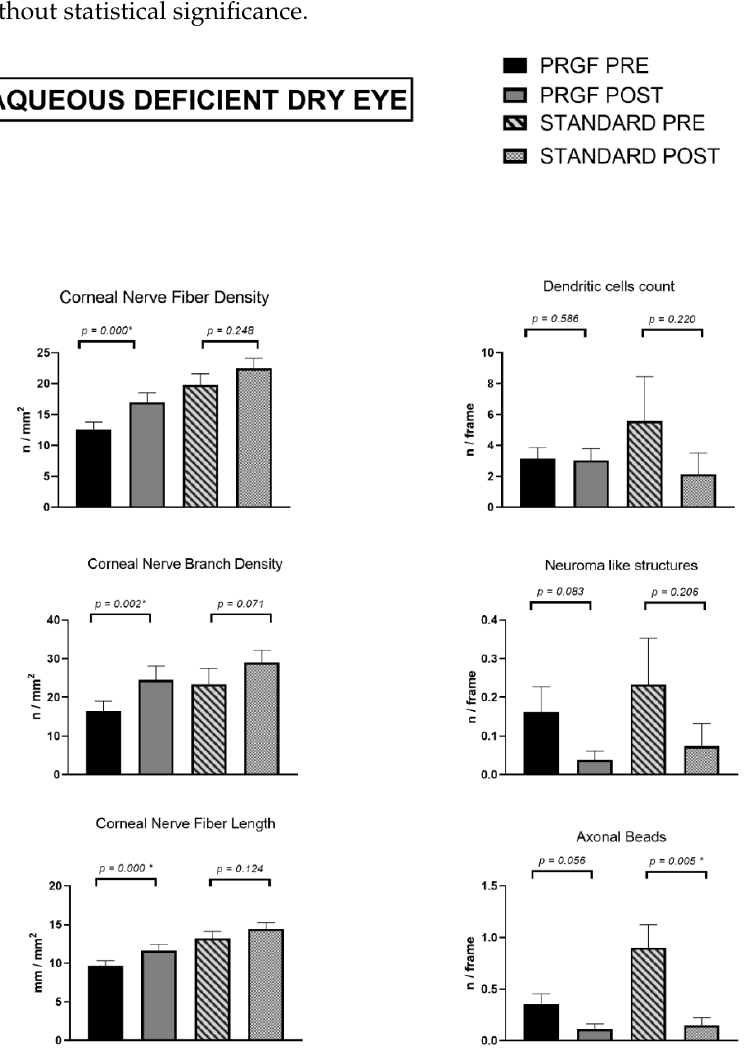
Figure 4. Corneal nerve quantification and morphological alterations ADDE subtype according to groups of treatment. Asterisks (*) in the graphs indicate statistical differences between groups ( p < 0.05).